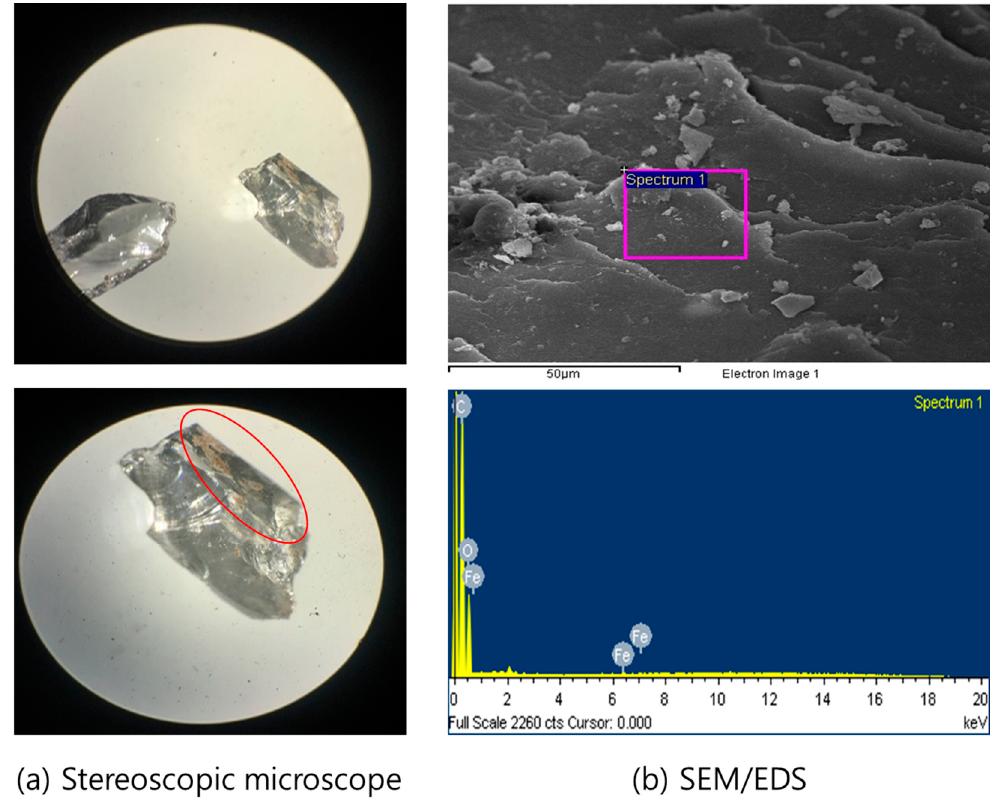
Figure 12. ( a ) Stereoscopic microscope of glass from ASR, ( b ) SEM and EDS of glass from ASR.